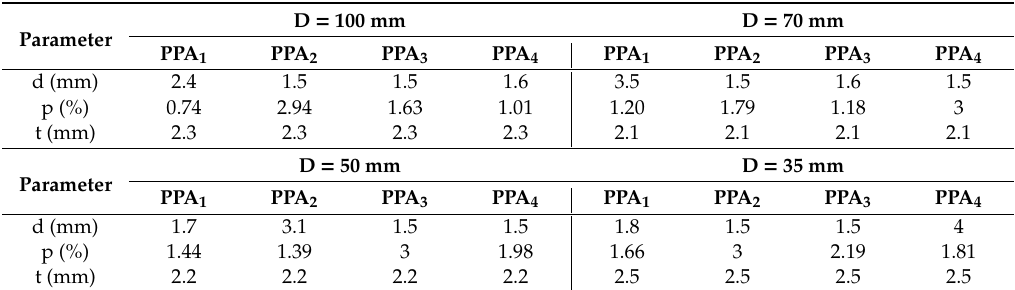
Figure 4. Optimization of the parallel-arranged PPAs with different cavity depth. Table 2. Optimization parameters of PPAs with different cavity depth.